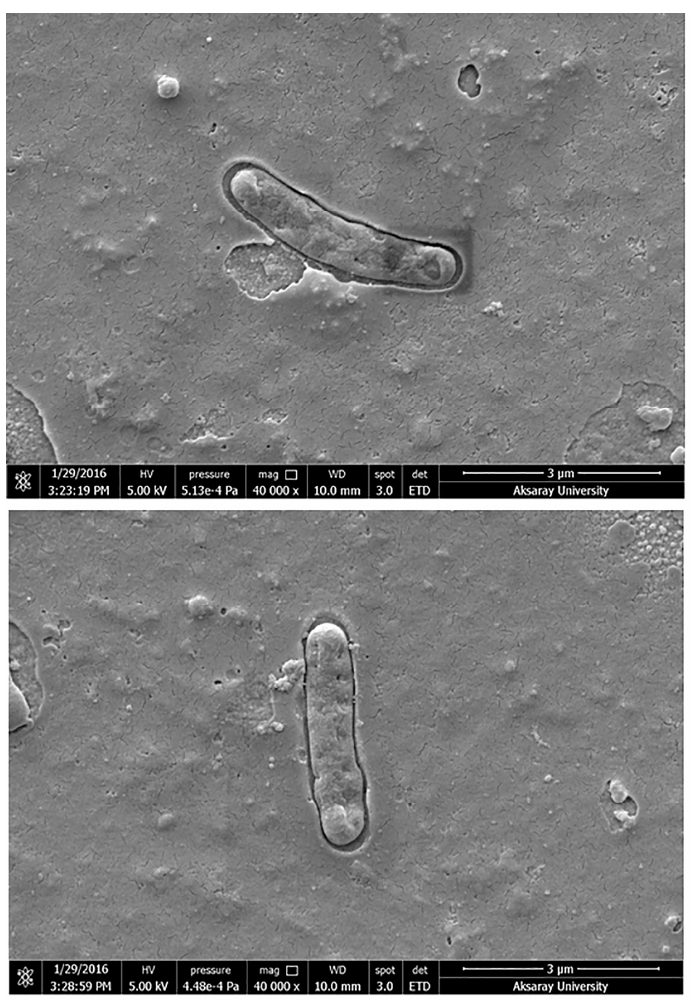
Figure 2. SEM images of microcontact S. paratyphi imprinted SPR chip surfaces indicating captured cells.